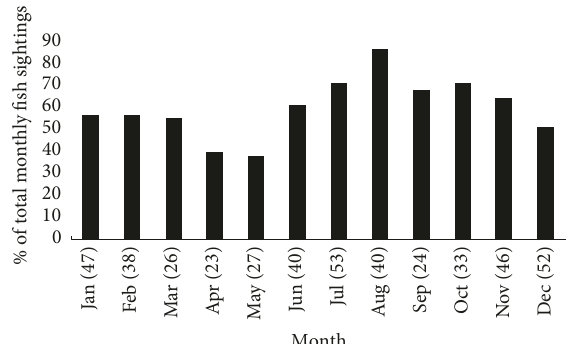
Figure 2: Percentage of total monthly fish sightings indicating presence of mola at PVR compiled from lists recorded aboard the National Geographic M/V Endeavor, Islander, and Polaris tourist vessels between January 2007 and January 2016. The number of available lists is in parentheses next to each